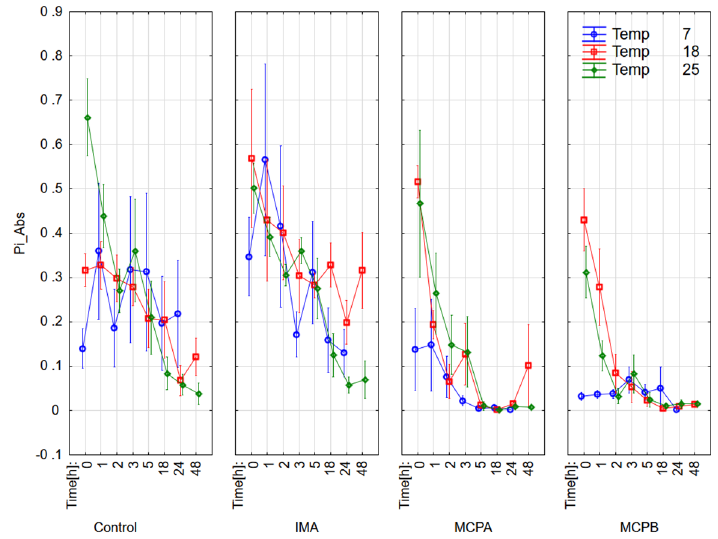
Figure 4. Effective quantum yields of particular photosynthetic processes in PSII (Phi_Pav, Phi_Do, Phi_Eo and Psi_Eo) as affected by MCPA, MCPB and IMA in G. orientalis cultivated at three different temperatures (7, 18 and 25 °C). Data points represent means of five replicates ± standard deviation. The replicates were five leaves, each on a different plant.